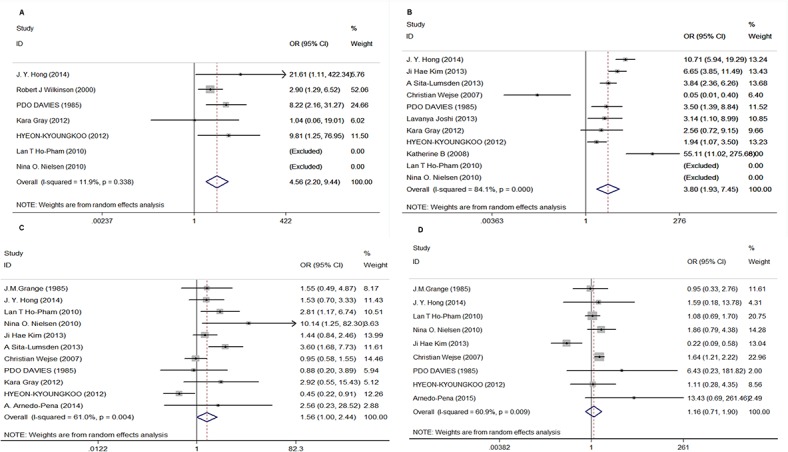
Forest plots of the overall association of susceptibility to tuberculosis and vitamin D deficiency.(a) serum 25(OH)D ≤ 12.5nmol/L; (b) serum 25(OH)D between 12.5 and 25nmol/L; (c) serum 25(OH)D between 26-50nmol/L; (d)serum 25(OH)D between 50 and 75nmol/L.